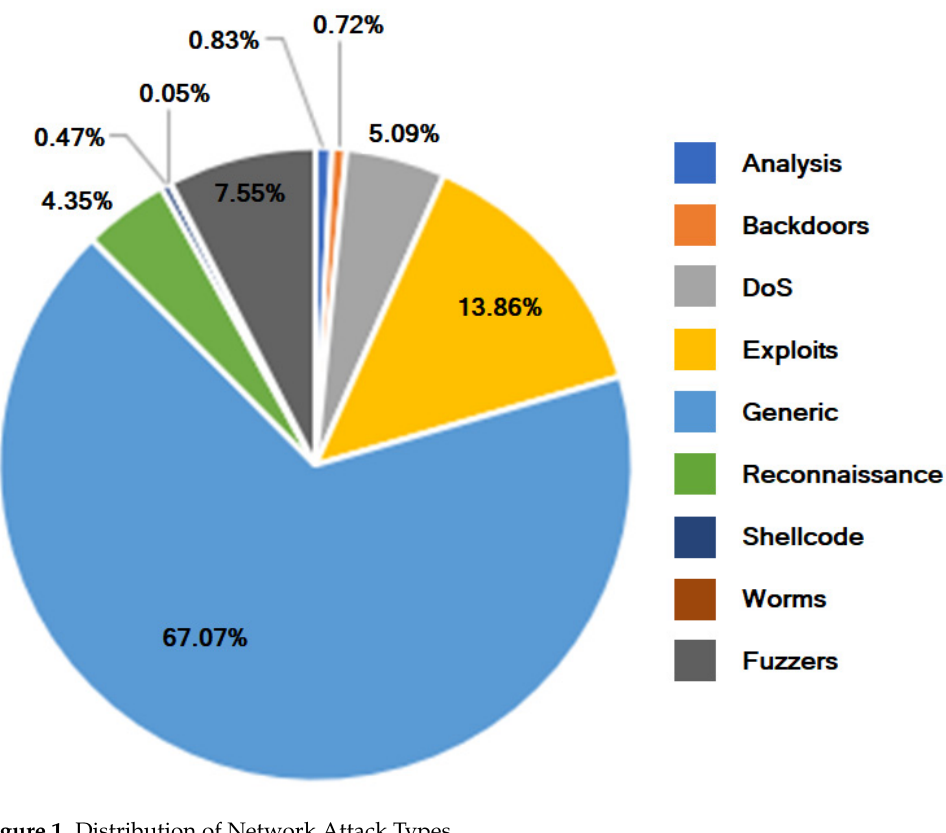
Figure 1. Distribution of Network Attack Types.